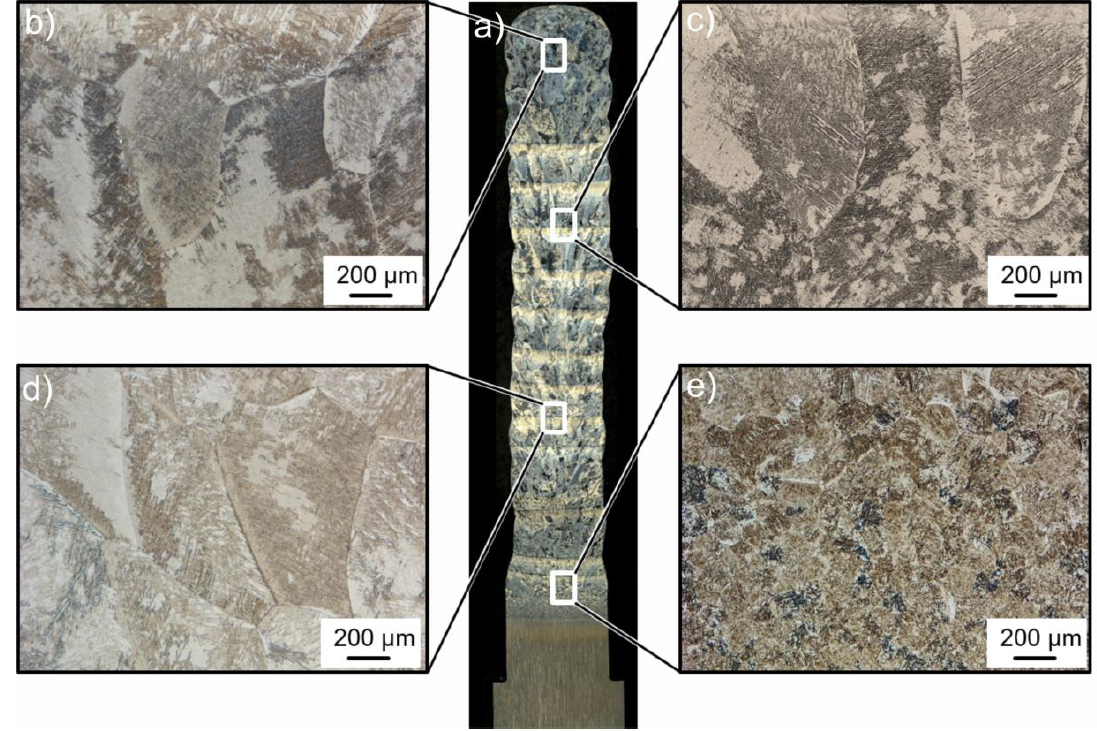
Figure 5. ( a ) Micrograph showing prior β-Ti grains in the middle section of the sample with enlarged view for ( b ) top of WAAM part, ( c ) and ( d ) middle height of WAAM part, ( e ) transition region between WAAM and forged parts.